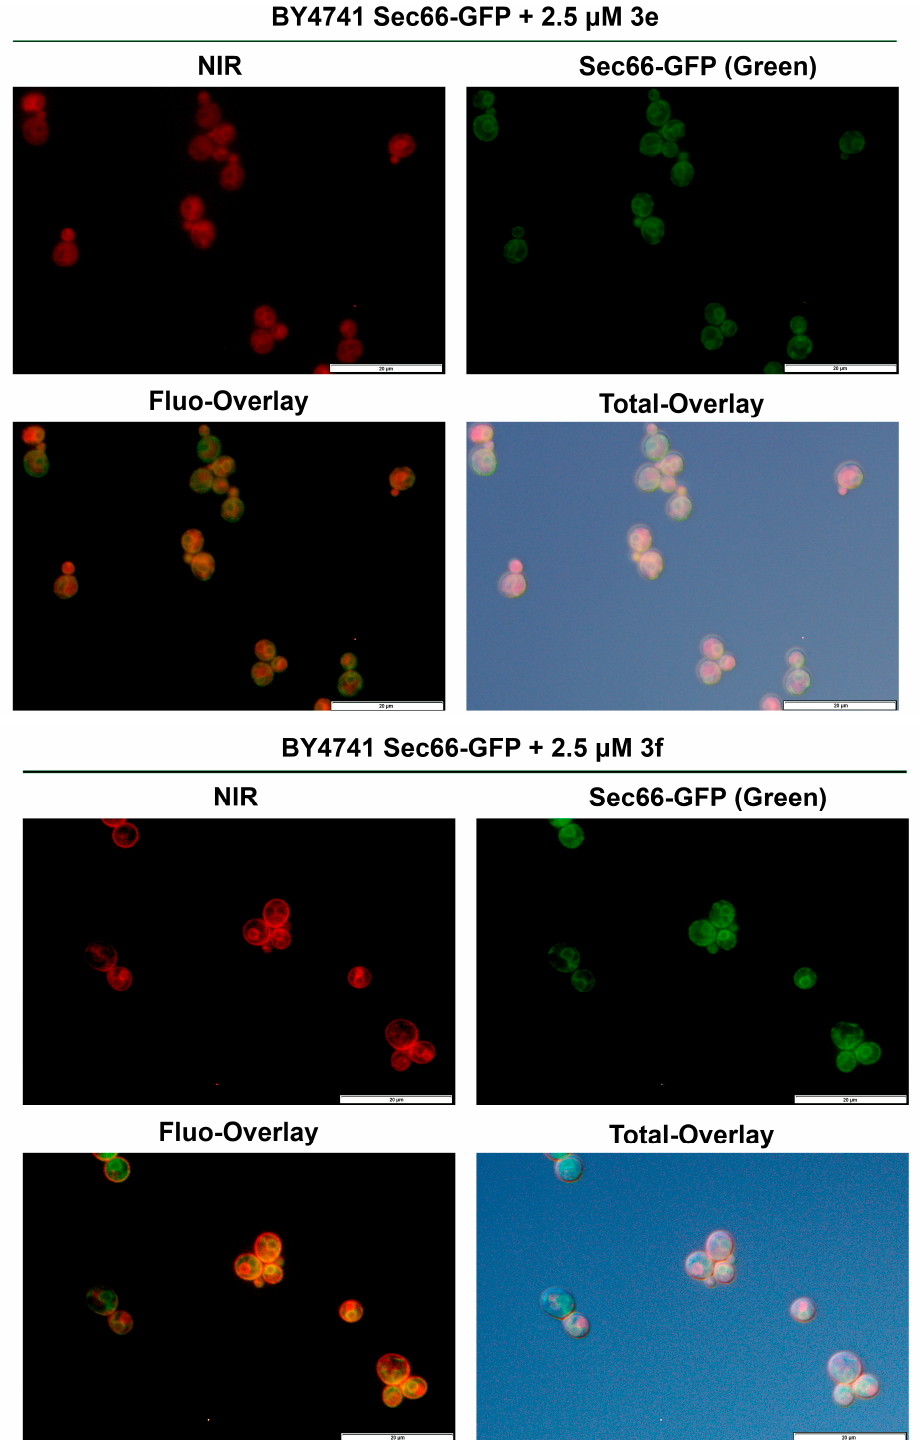
Figure 3. Co-localization of benzo[ a ]phenoxazinium chlorides 3a–f with perinuclear membrane of the endoplasmic reticulum. Fluorescence microscopy images of BY4741 Sec66-GFP cells after incubation with 3a–f (2.5 µ M) for 1 h. Samples were rinsed two times in PBS 1 × and mounted on a slide for observation with a 60 × oil immersion objective, using the adequate filters U-FDICT, ET-CY5-FAR-RED (exciter filter: 595–645 nm/emission filter: 665–715 nm), and TLV-U-FF-FITC (exciter filter: 455–495 nm/emission filter: 505–555 nm). Representative images of three independent experiments. Scale bar 20 µ